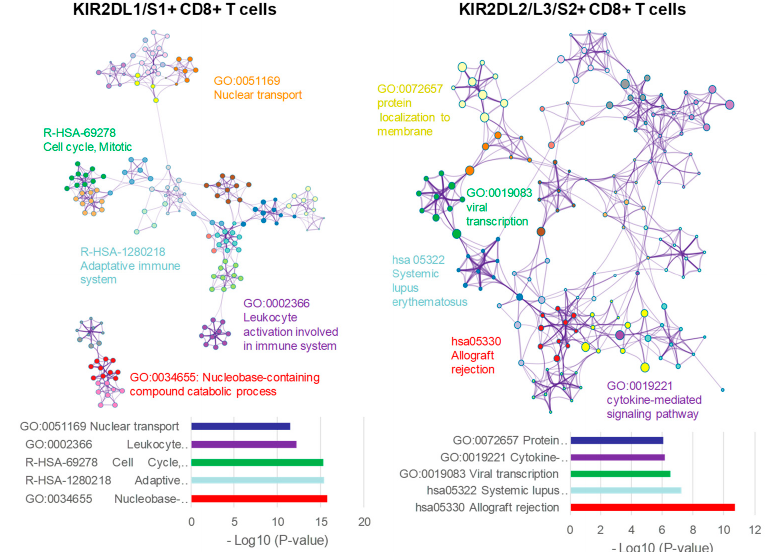
Figure 6. Functional enrichment analysis with Metascape of KIR2DL1/S1+ and KIR2DL2/L3/S2+ CD8+ T cell populations.Network of enriched terms colored by cluster ID, where nodes that share the same cluster ID are typically close to each other. On the left (KIR2DL1/S1+ CD8+ T cells) and right (KIR2DL2/L3/S2+ CD8+ T cells) DEGs where analyzed and the five top clusters with their representative enriched terms are shown.